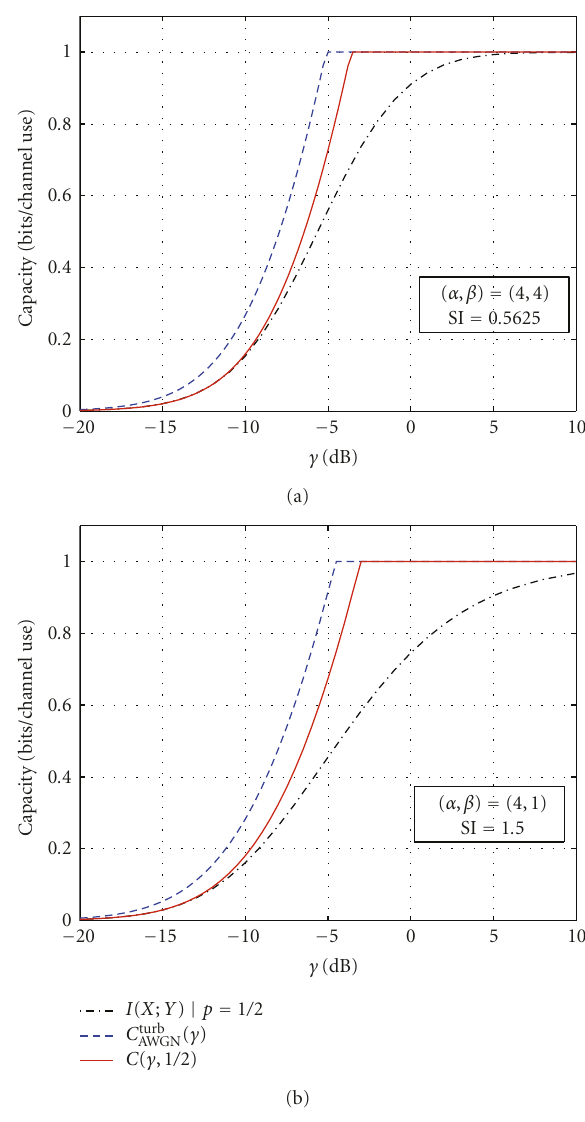
Figure 3: Capacity bounds and mutual information numerically solved for the atmospheric turbulent optical channel with uniform input distribution when κ = 20, a rectangular pulse shape with ξ = 1, and di ff erent levels of turbulence strength (a) ( α , β ) = (4,4) and (b) ( α , β ) = (4,1) are